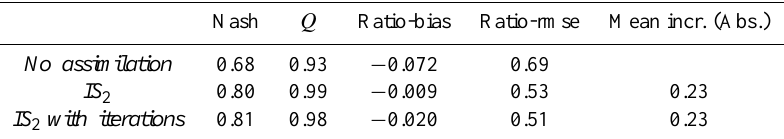
Table 5. Statistical scores for SIM discharges and the BLUE assimilation system for a set of 148 assimilated stations. Scores are averaged over a 19-month period (10 March 2005–30 September 2006). “No assimilation” was the experiment without data assimilation but using the improved physics, “ IS 2 ” used the data assimilation system, and “ IS 2 with iterations” was the data assimilation experiment using the BLUE iterations until convergence. The three experiments used the improved